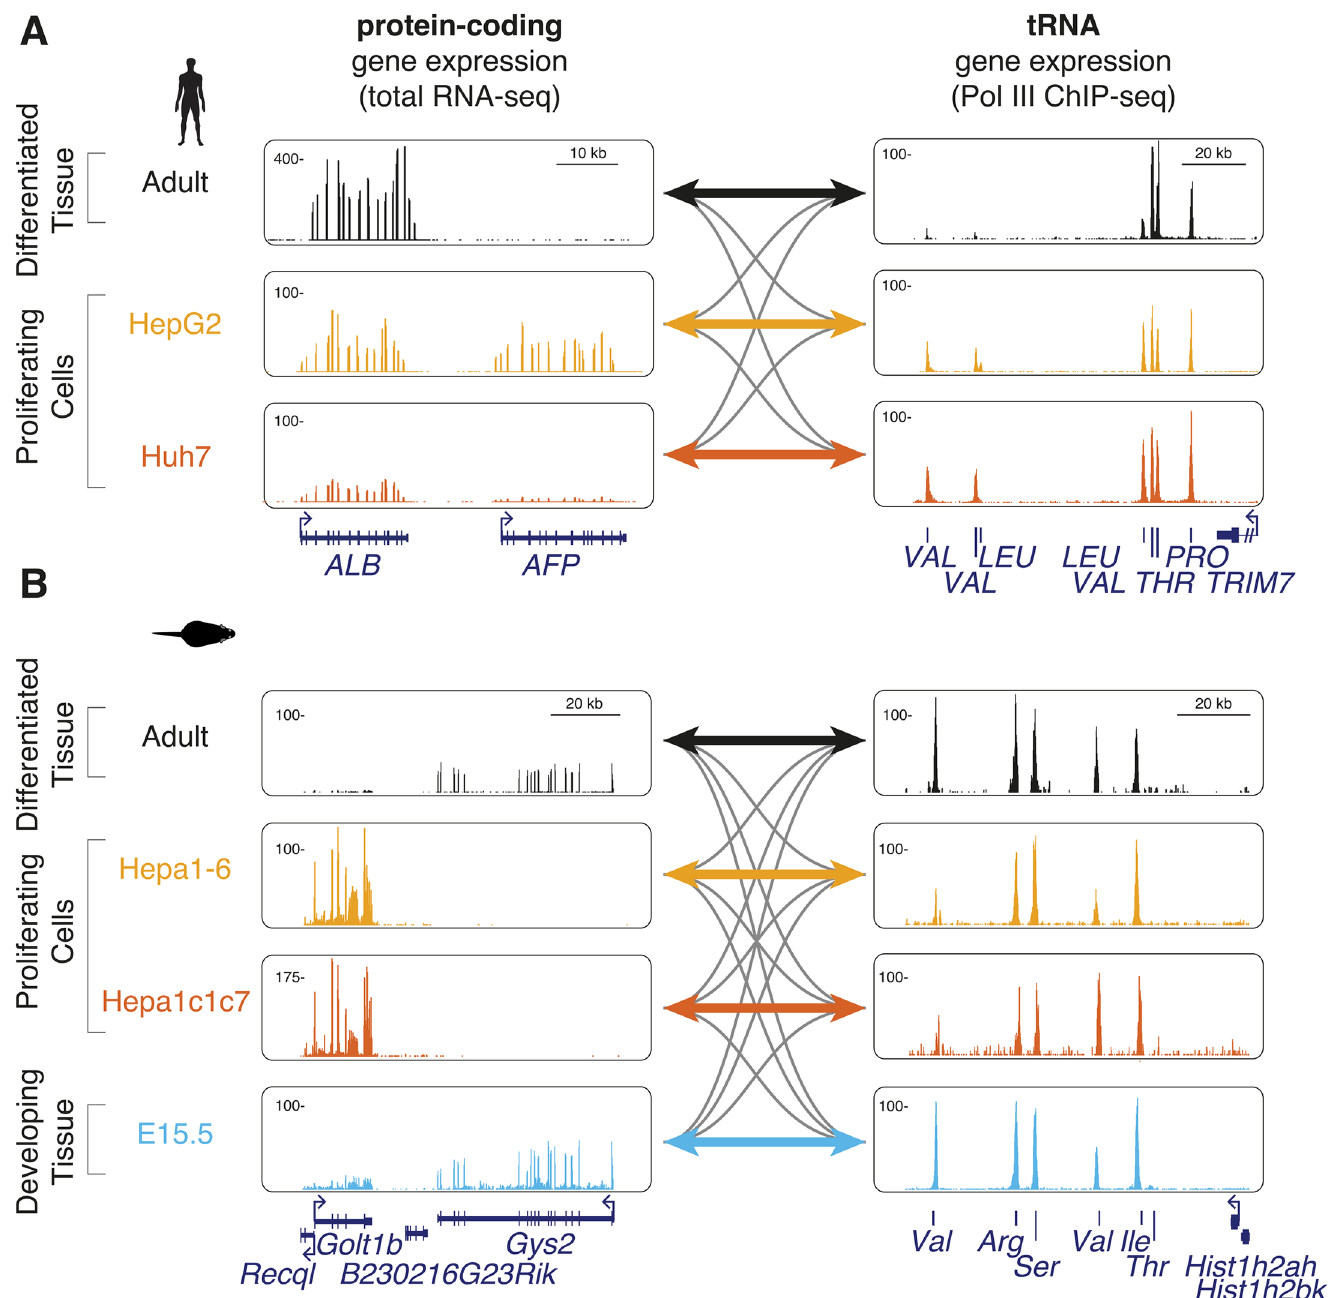
Fig 2. Cell type-specific expression of protein-coding and tRNA genes. Protein-coding and tRNA gene expression levels in ( A ) human and ( B ) mouse were measured in proliferating hepatic cells (HepG2 and Huh7 in human, Hepa1-6 and Hepa1c1c7 in mouse; yellow and red tracks), quiescent adult (black tracks) and developing embryonic E15.5 (blue tracks) liver tissue. Shown are examples of differentially regulated protein-coding (left) and tRNA (right) genes. Colored and grey bidirectional arrows represent the matching and mismatching codon – anticodon conditions compared, respectively. The y-axis of each track specifies normalized read density. Scale bars show length of genomic regions in kilobases (kb).